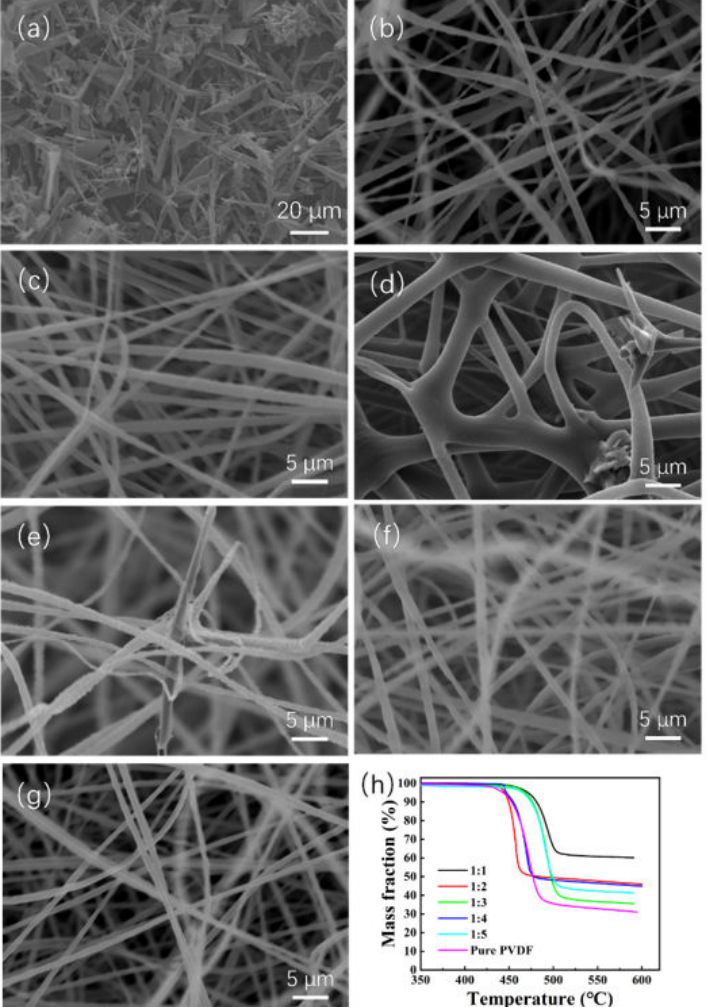
Figure 1. ( a ) SEM image of tetrapodal ZnO. ( b – f ) SEM images of the electrospinning ZnO@PVDF composite membranes with mass ratios of ZnO:PVDF = 1:1 ( b ), 1:2 ( c ), 1:3 ( d ), 1:4 ( e ), and 1:5 ( f ). ( g ) SEM image of the electrospinning pure PVDF membrane. ( h ) TG curves of the ZnO@PVDF composite membranes with different ZnO:PVDF mass